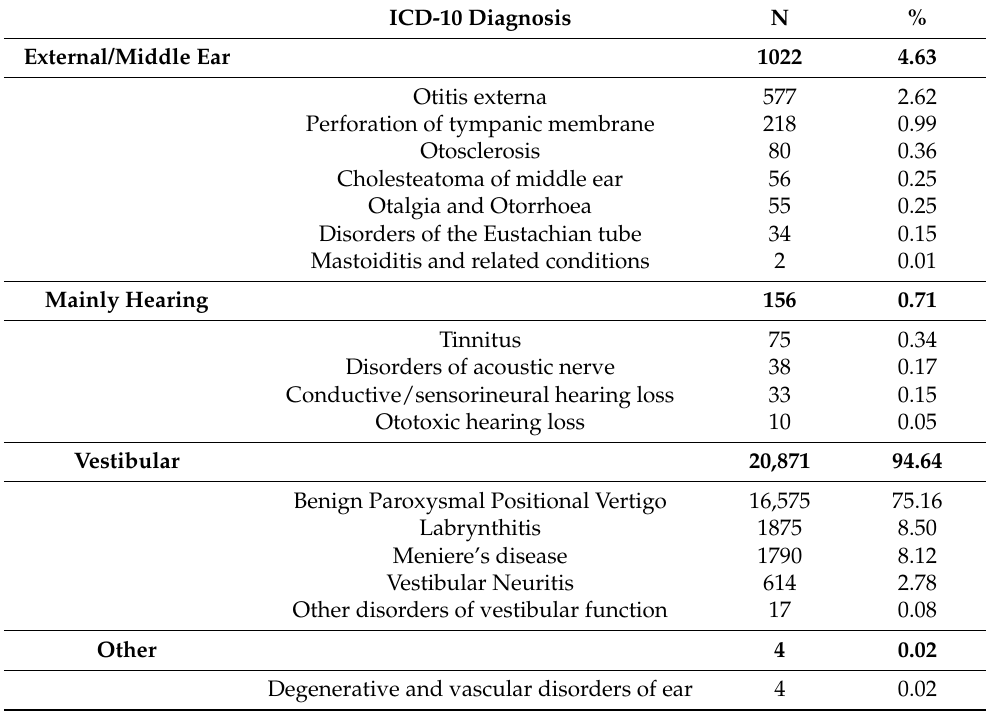
Table 1. Absolute number and frequency of new sick leave certificates related to ear diagnoses, according to Chapter VIII of the International Classification of Diseases, 10th Revision [12].